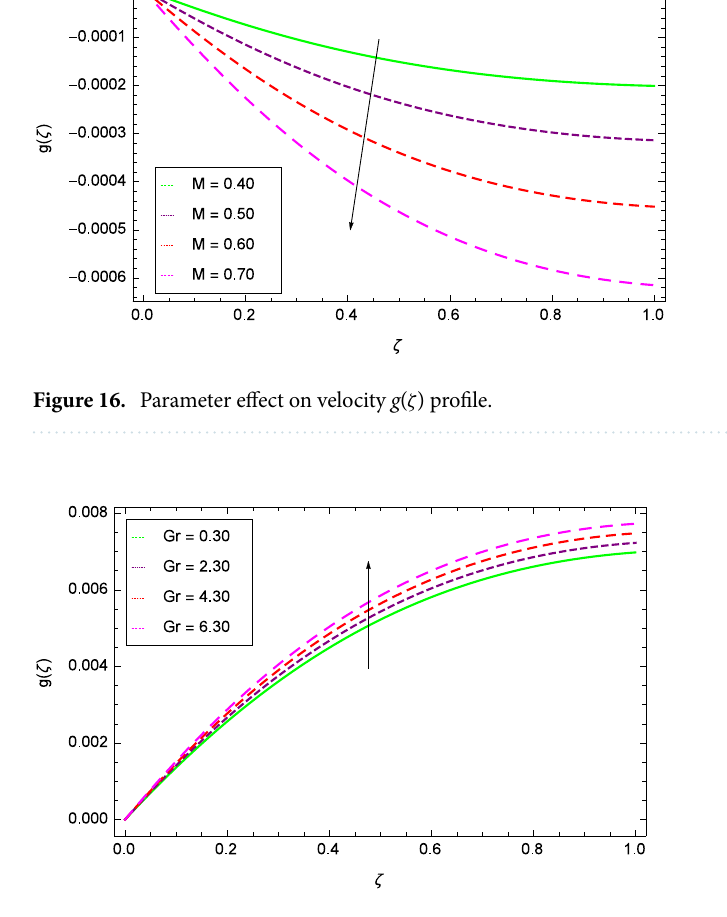
Figure 17. Parameter effect on velocity g ( ζ ) profile.